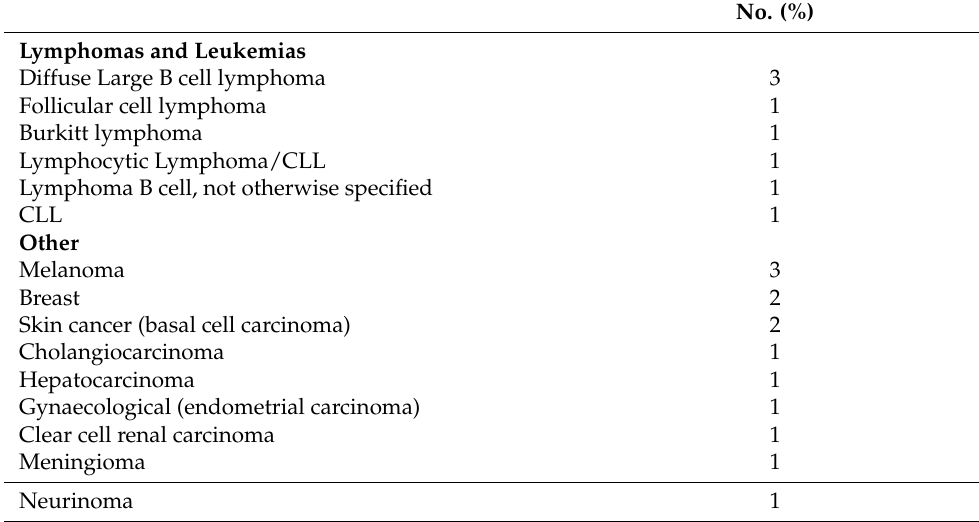
Table 2. Lymphomas and other